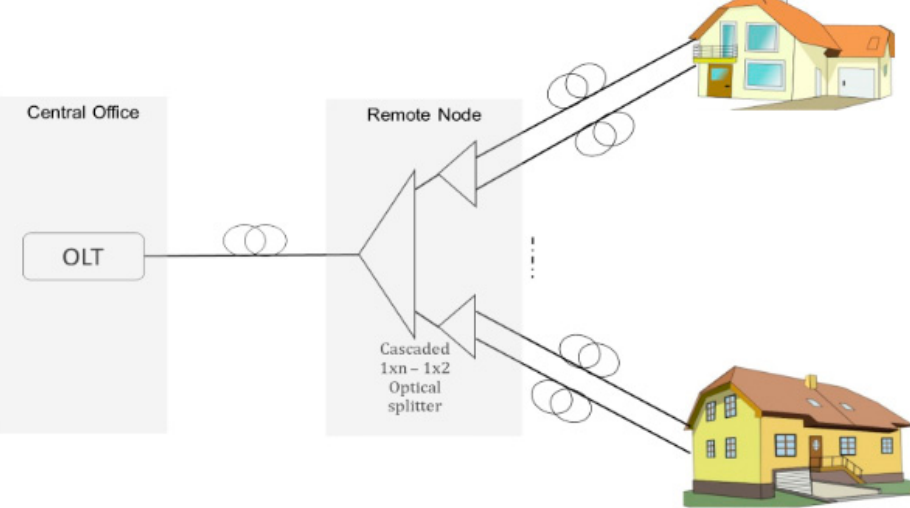
Figure 4. Proposed protection scheme in distribution segment.